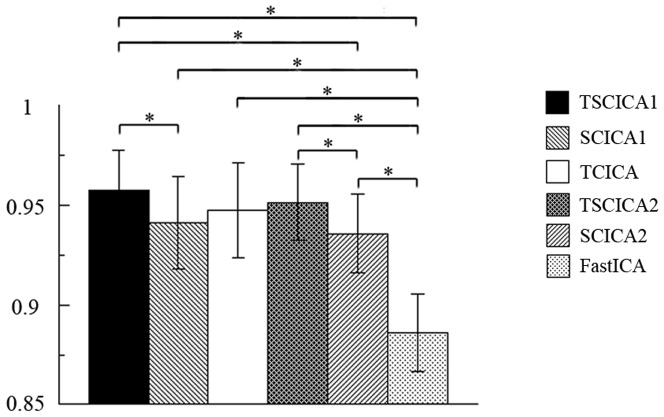
Mean cluster quality index of all the ICA methods.The error bar represents the standard deviation. Note: asterisk represents P<0.01.